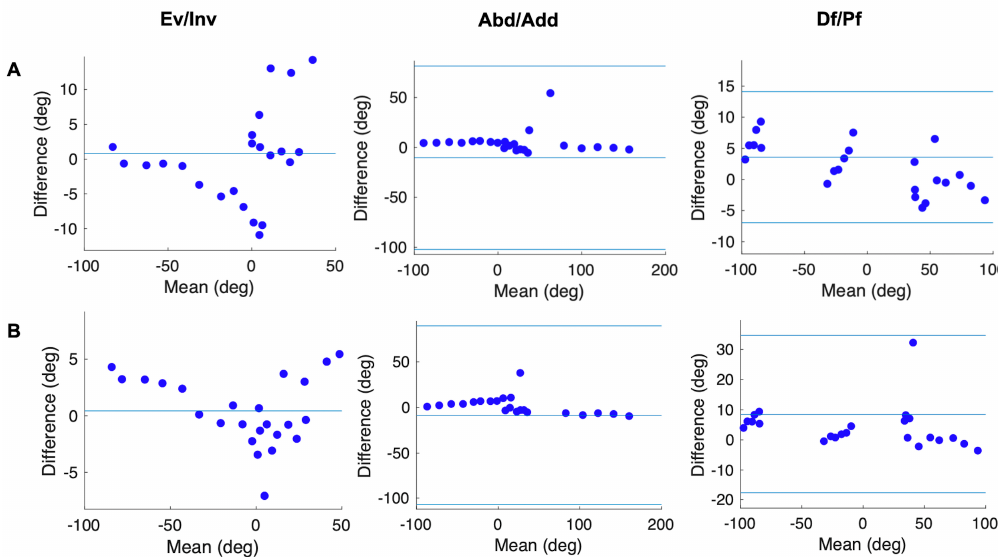
Figure 7. Bland-Altman plots showing the di ff erences between the true values of Met_Hal angle and Met_Hal angle calculated according to the two models: ( A ) our new model and ( B ) the Rizzoli model, against their means. When they do not have either a fixed or proportional bias, the mean is shown (one blue solid line). When they have a fixed or proportional bias, the mean (the middle one of three blue solid lines) and limits of agreement are shown (the outer two of three blue solid